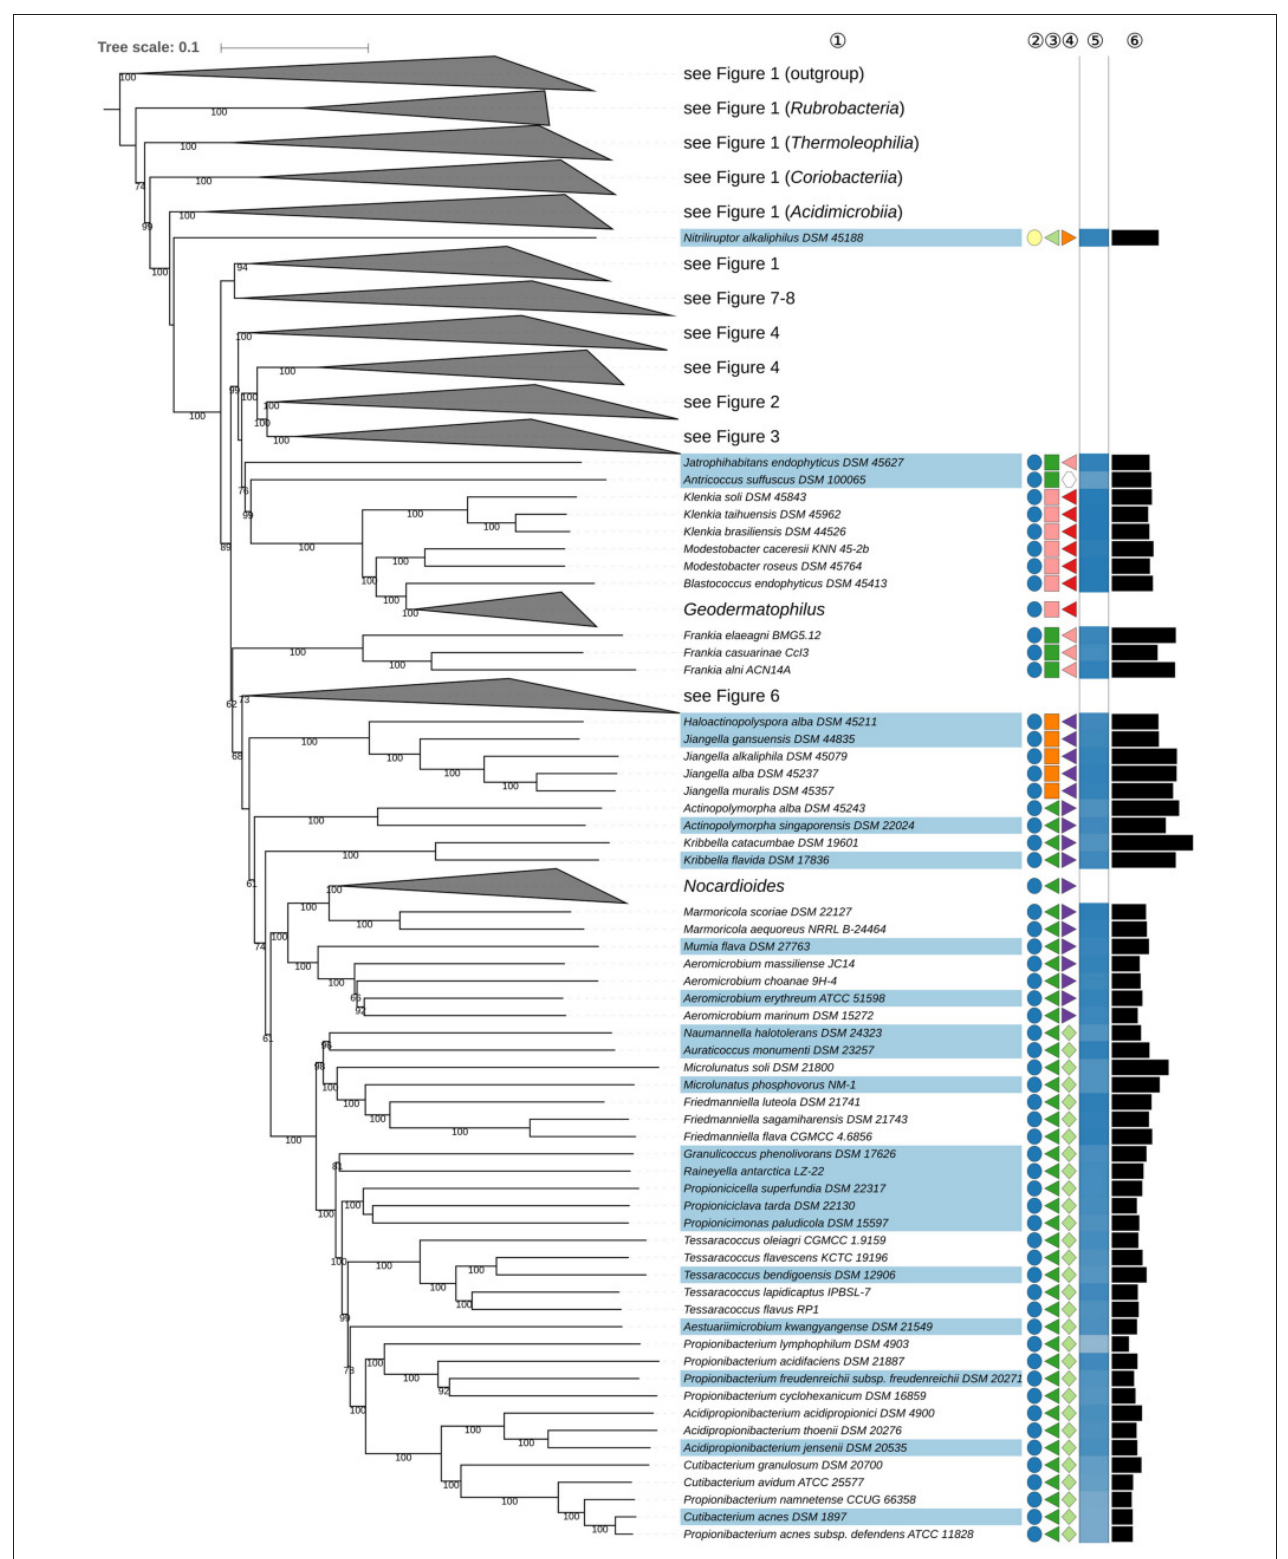
FIGURE 5 | Fifth part of the phylogenomic tree inferred with GBDP. A detailed description is provided in the caption of Figure 1 . The parts of the tree which have been collapsed here are shown in other figures as indicated.